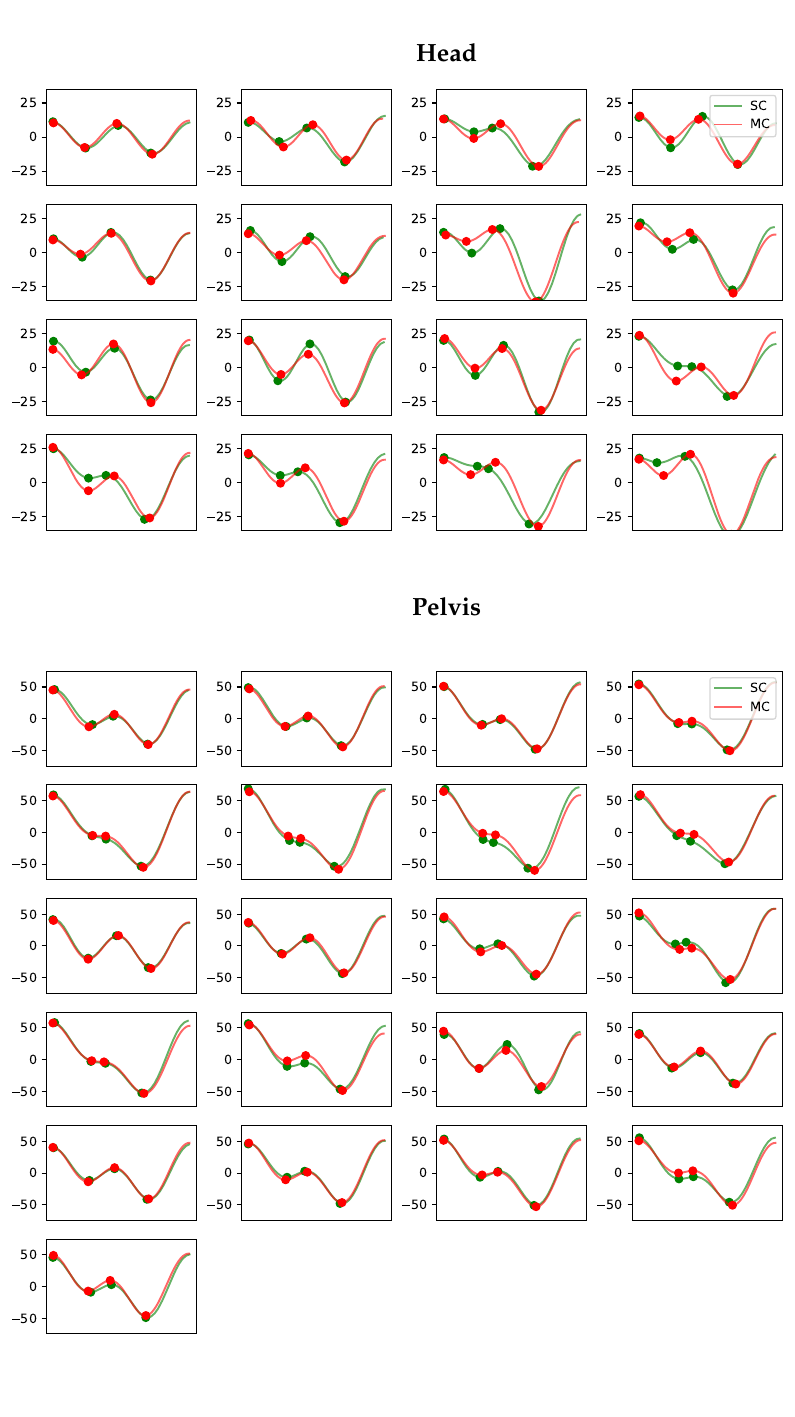
Figure A20. Vertical displacement signals per stride for the head and pelvis for horse 21. Each subplot contains the matched stride segments for the single-camera markerless system (SC) in green and the multi-camera marker-based system (MC) in red. The y-axis shows the vertical displacement in millimeters. The four dots on each curve indicate the positions of the two peaks and two valleys extracted using the approach in Section